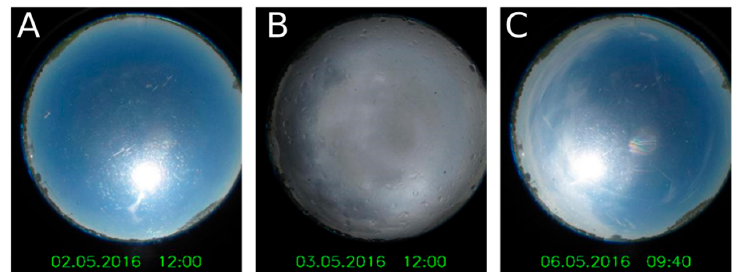
, (cid:1856)(cid:1858) and (cid:1856)(cid:1858) to one single (cid:1856)(cid:1858) , depending on 1 2 3